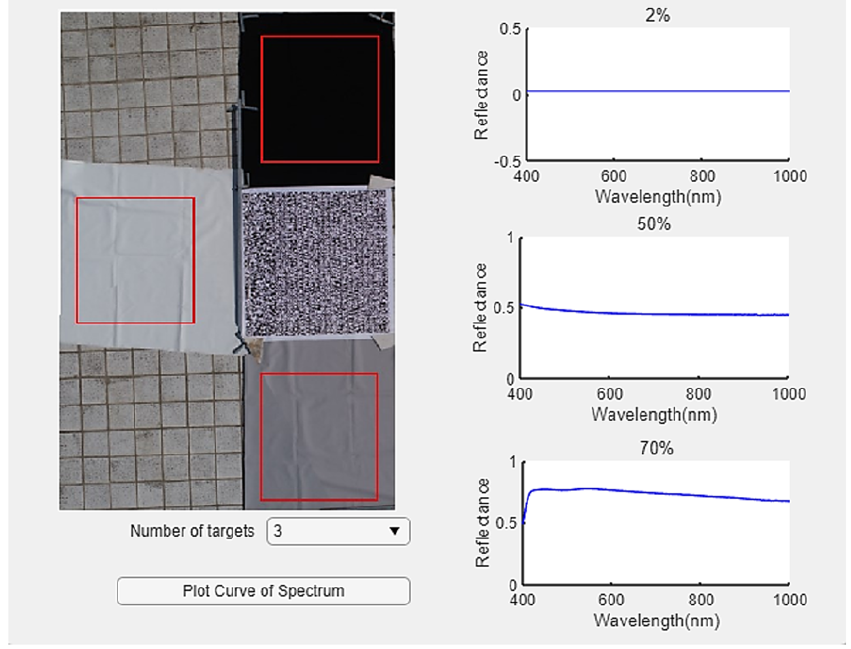
Figure 3. The interface of QR code target extraction system.